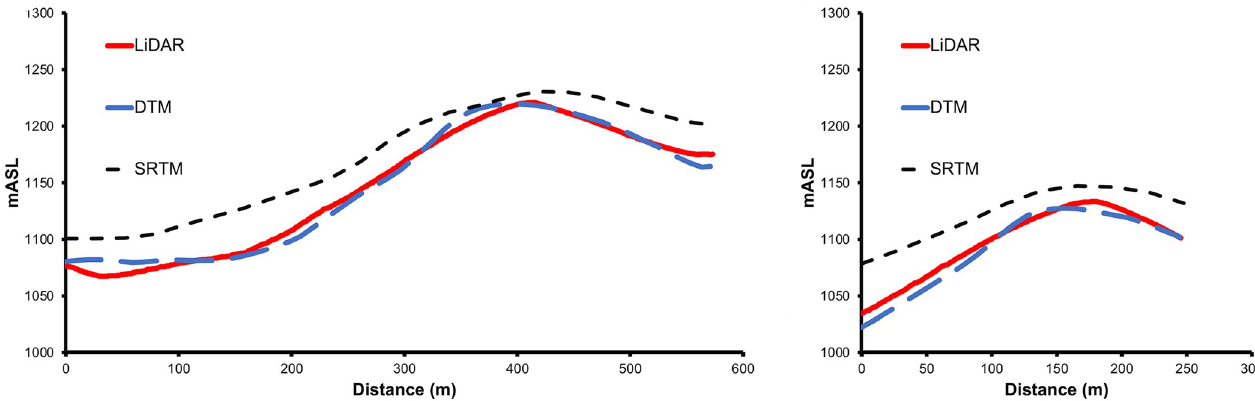
Fig 10. Slope comparisons along transects across the area of Cutblock 318-512-0009 (left) and the Cutblock 318-512-0010 (right).